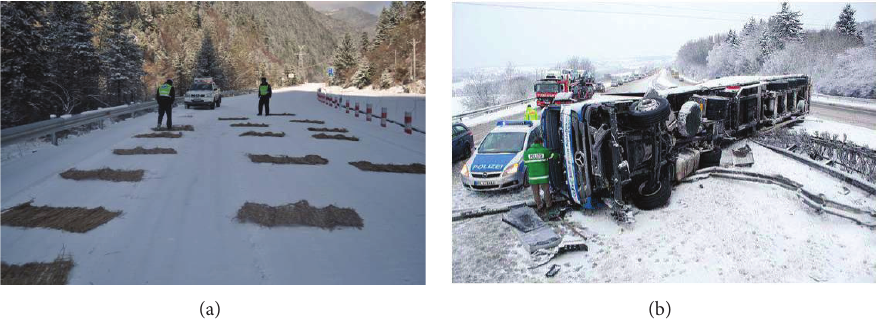
Figure 1: Influence of the snow and ice road on traffic safety.